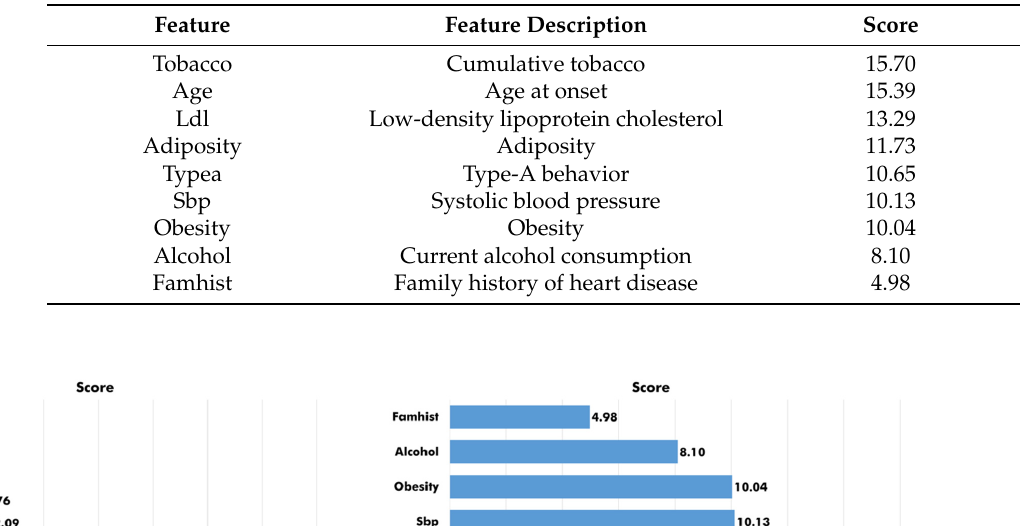
Table 6. Main attributes on the South African Hearth dataset identified with Random Forest.